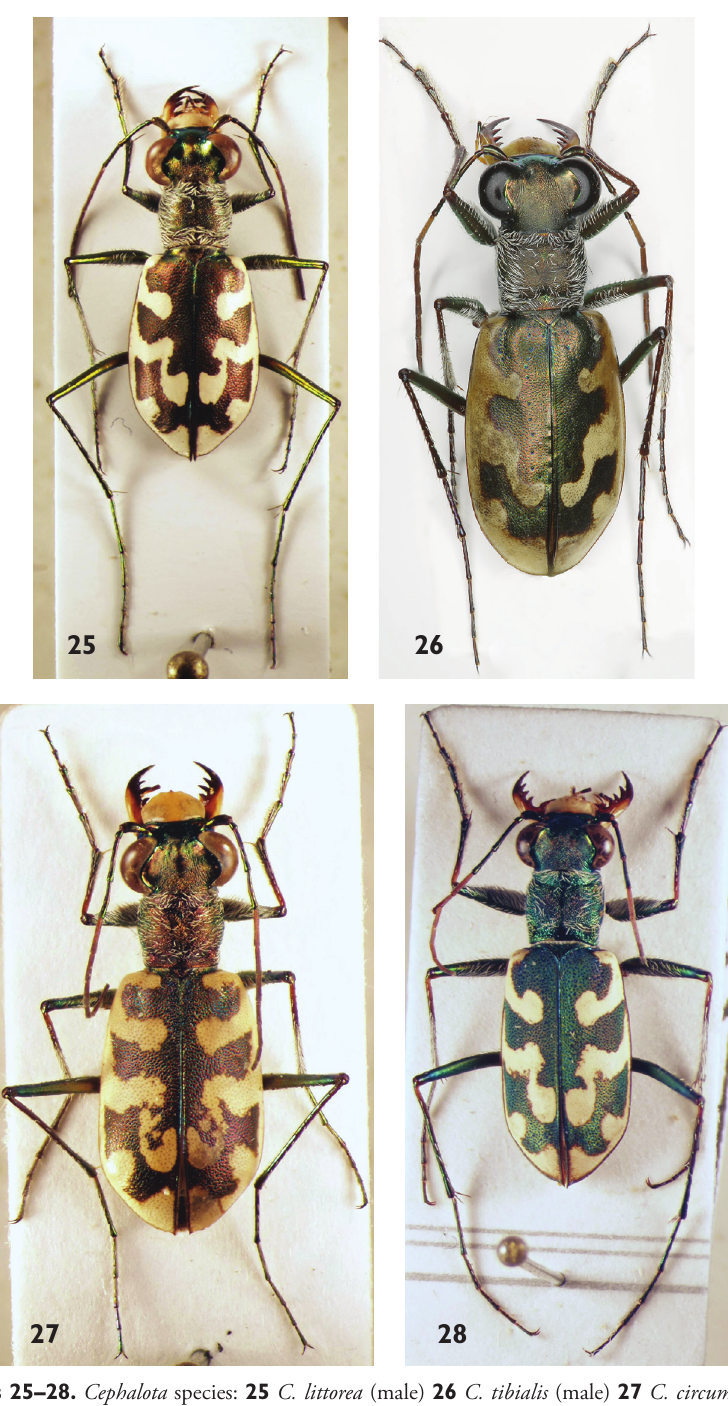
Figures 25–28. Cephalota species: 25 C. littorea (male) 26 C. tibialis (male) 27 C. circumdata (male) 28 C. vartianorum